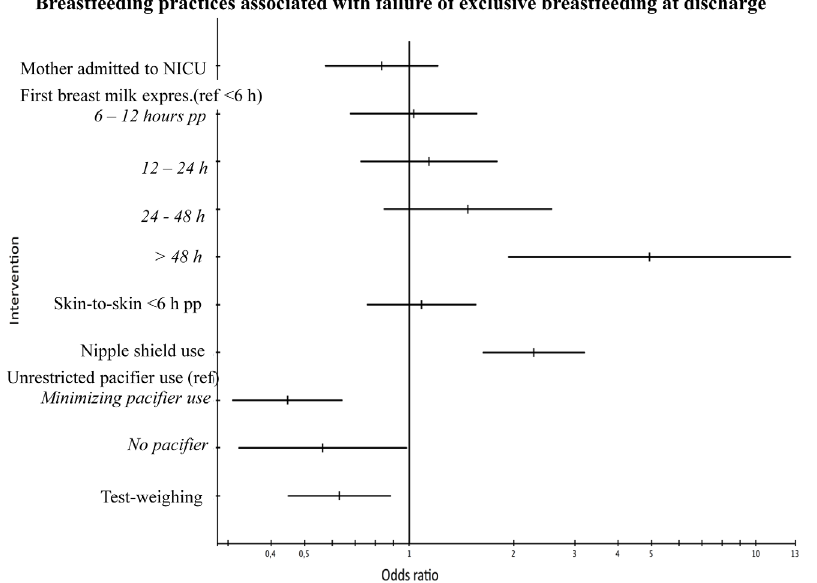
Figure 2. Forest plot. BM expres. = Breast milk expression, h = hours, NICU = Neonatal Intensive Care Unit, pp = postpartum, ref = reference.